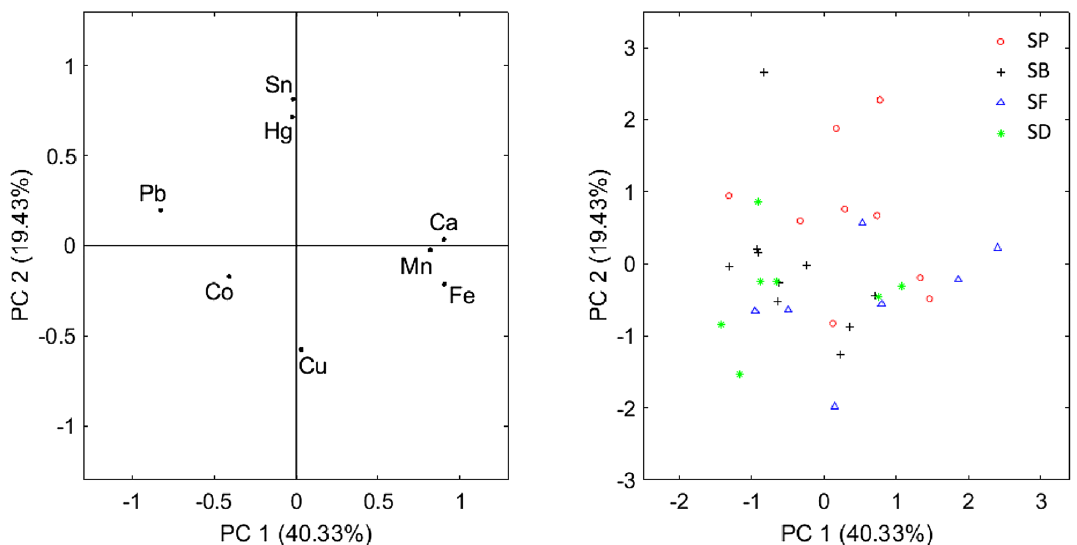
Figure 8. PCA scores (left) and results of the PCA analysis applied to the pigments of vegetation, rocks, and ground